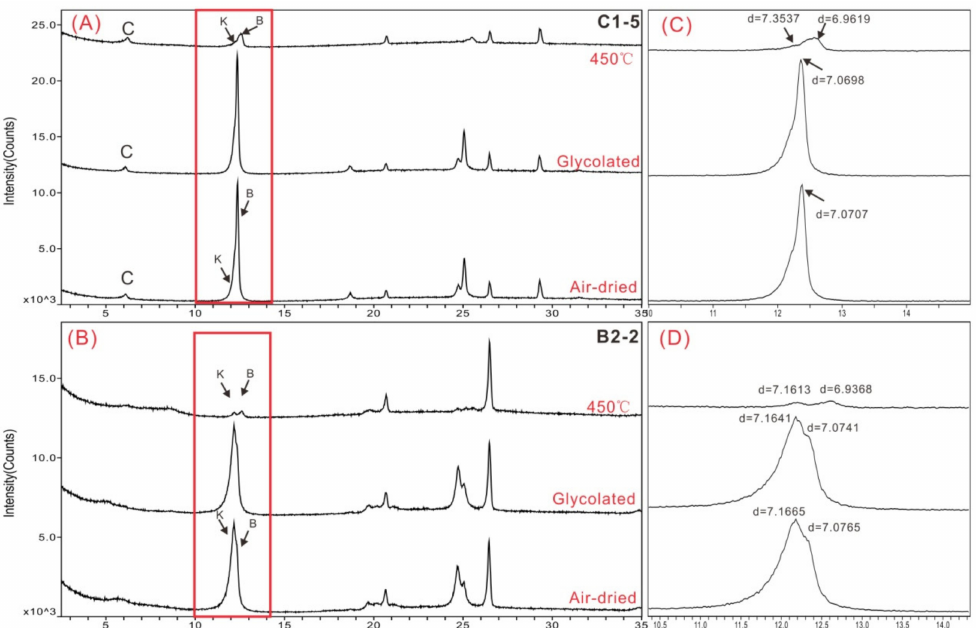
Figure 4. X-ray diffraction (XRD) patterns from air-dried, glycolated, and heated orientated sample of the <2 µ m clay- Figure 1. ( A ) and B2-2 ( B ). ( C ) and ( D ) are enlargement of the specific area in ( A , B ). K: kaolinite. B: berthierine. C: